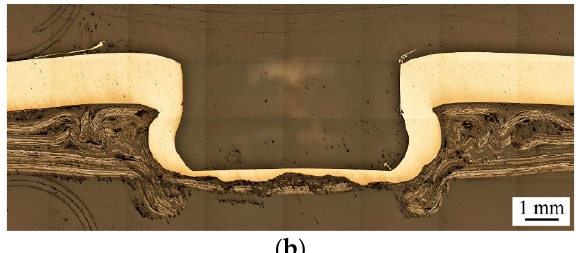
Figure 11. Cross-sectional micrographs of clinch joints made by ( a ) Die D1 ( d d : 0.7 mm), and ( b ) Die D2 ( d d : 0.4 mm). The Punch P1, punching force of 69 kN, heating temperature of 100 ◦ C and Heating Mode B are used.